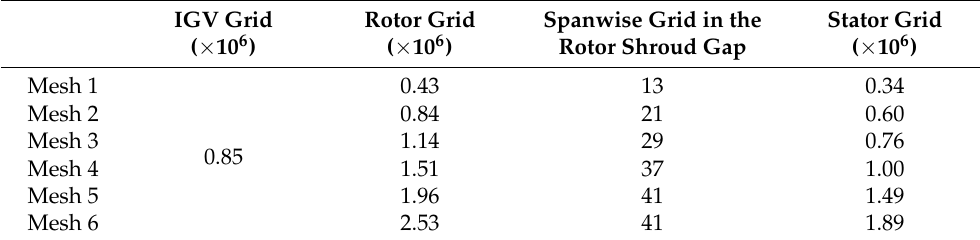
Table 2. Grid parameters for the grid independence study.